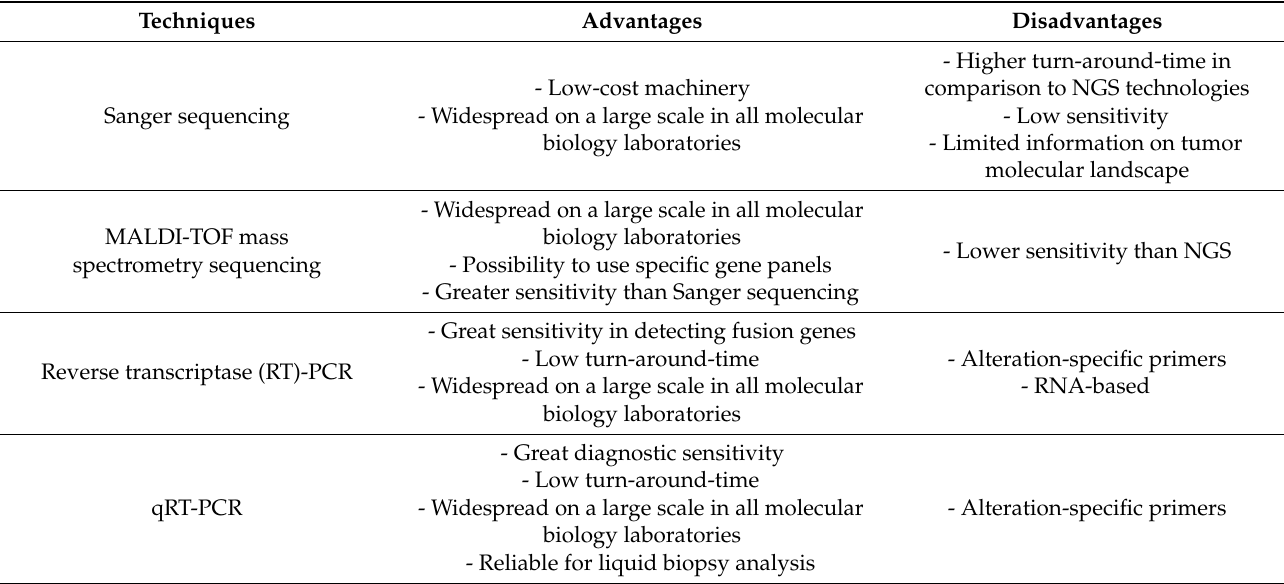
Table 2. Major available techniques in molecular diagnostics in the